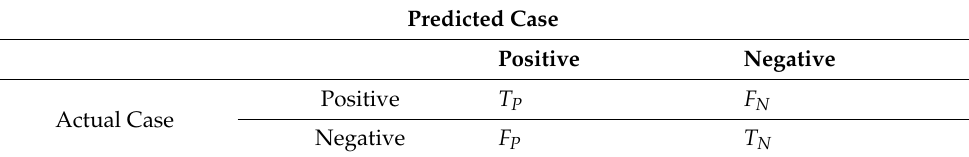
Table 2. Confusion